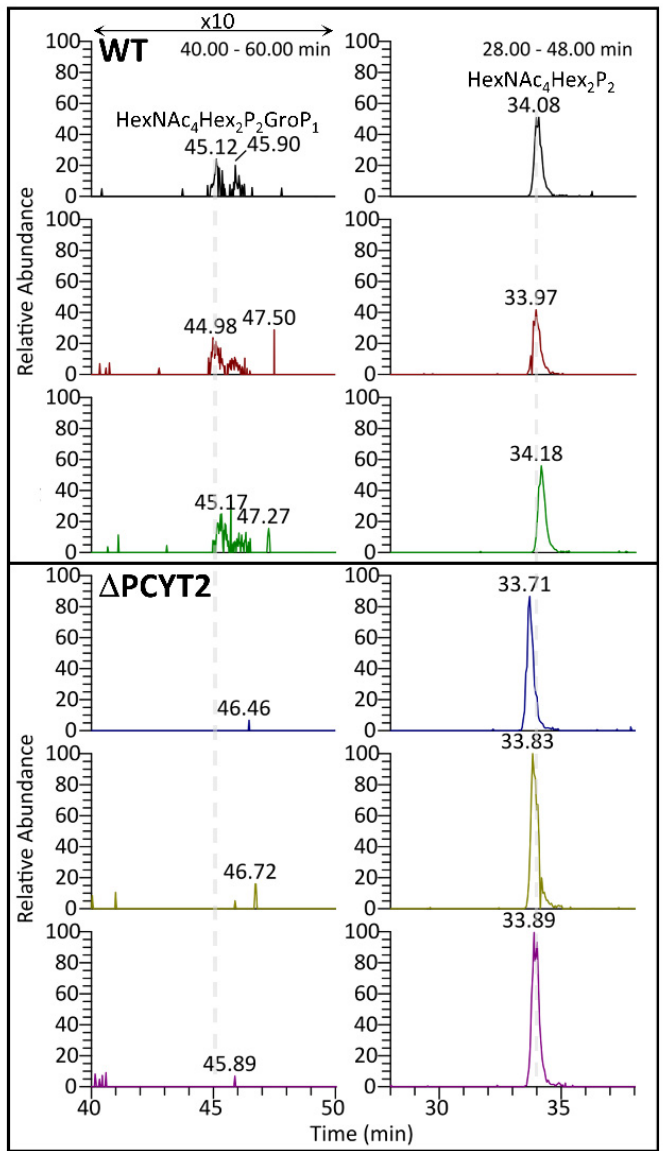
Figure 5. Glycan modification on α -DG373(T322R)-Fc expressed in HCT116 wild-type and PCYT2- KO cells. The extracted ion chromatograms of selected 313 pyrQIHATPTPVR 322 on α -DG carrying phosphorylated core M3 glycoforms, HexNAc 4 Hex 2 P 2 GroP 1 ( left ) and HexNAc 4 Hex 2 P 2 ( right ), in biological triplicate of WT (upper 3 panels) and ∆ PCYT2 (lower 3 panels) derived from HCT116. The HexNAc 4 Hex 2 P 2 GroP 1 glycoforms were only detected in WT, but not ∆ PCYT2, in contrast with the detections of phosphorylated core M3 structures, HexNAc 4 Hex 2 P 2 GroP 1